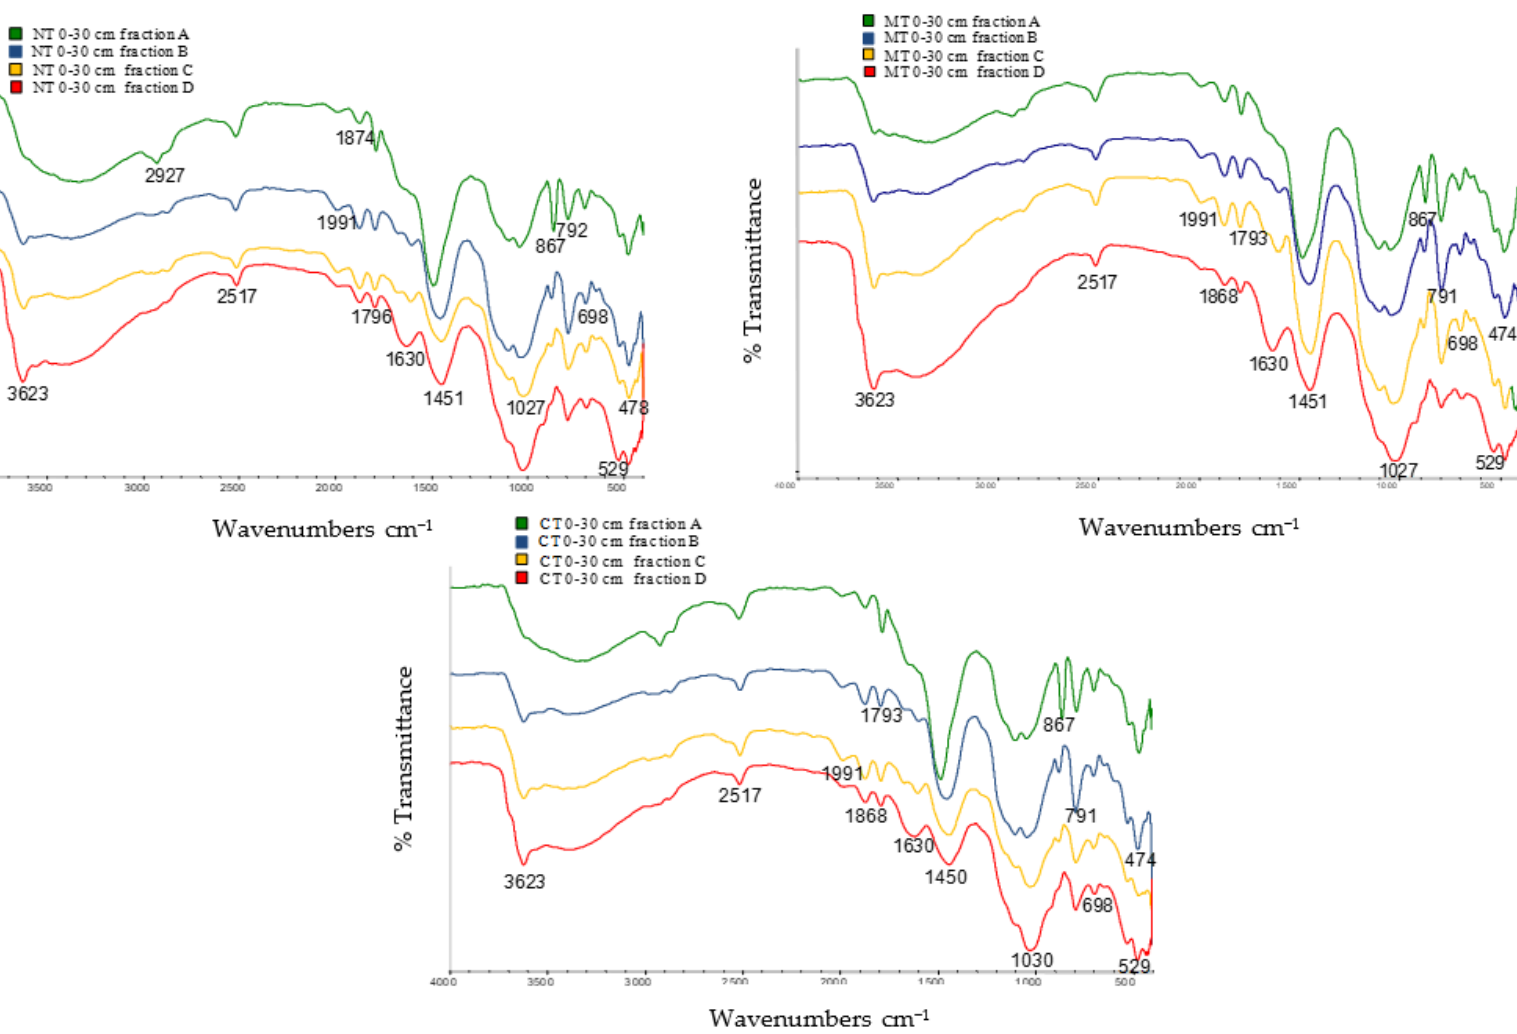
Figure 2. Diffuse reflectance infrared Fourier transform spectra of all soil fractions isolated from different tillage treatments at 0–30 cm of depth.